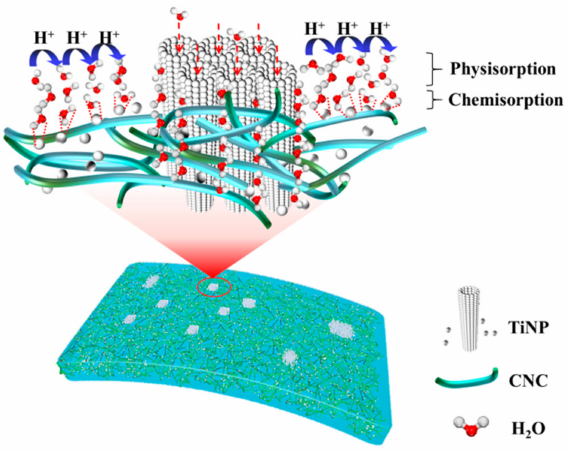
Figure 9. A schematic illustration of the humidity sensing mechanism of the TiNP/CNC-based humidity